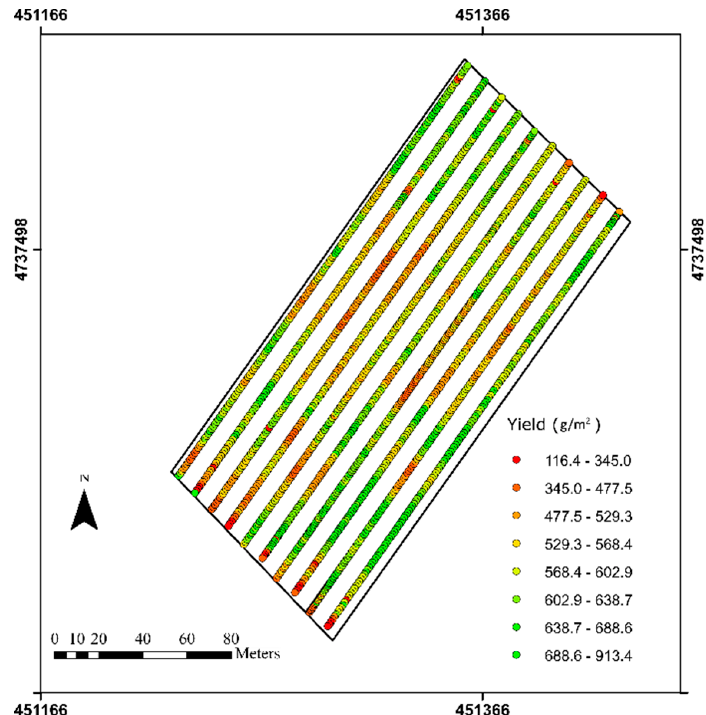
Figure 2. Winter wheat yield map generated from combine harvester for S2.